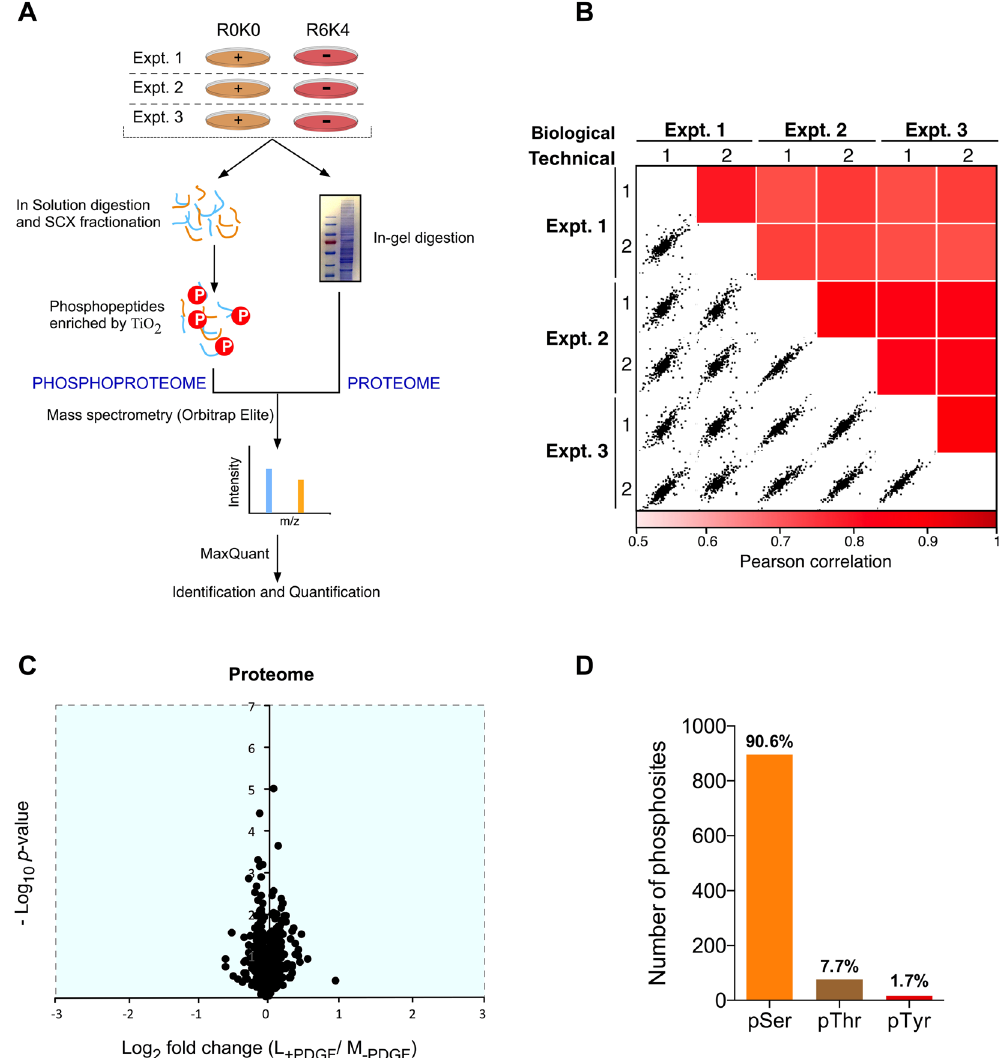
Figure 1. Global quantitative proteomics and phosphoproteomics of PDGF signalling in mouse embryo fibroblasts (MEFs). ( A ) Schematic overview of experimental design. SILAC labelled MEFs were stimulated with PDGF for 7 min ( + ) or left unstimulated ( − ). ( B ) Heat map of Pearson correlation coefficients and multi scatter plots demonstrating reproducibility between the phosphoproteome of biological and technical replicates. ( C ) Volcano plots showing the ratio (log2 fold change) and significance ( − log10 Benjamini-Hochberg adjusted p - value) of the proteome dataset. ( D ) Numbers of serine, threonine and tyrosine phosphorylation sites identified within our PDGF-regulated phosphoproteome